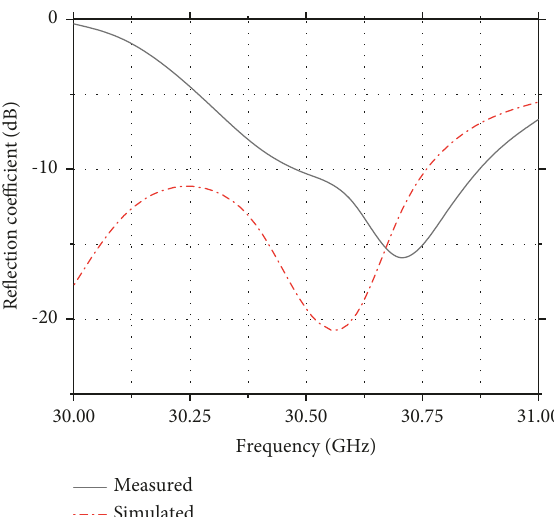
Figure 9: A comparison between the measured and simulated reflection coefficients of the 2